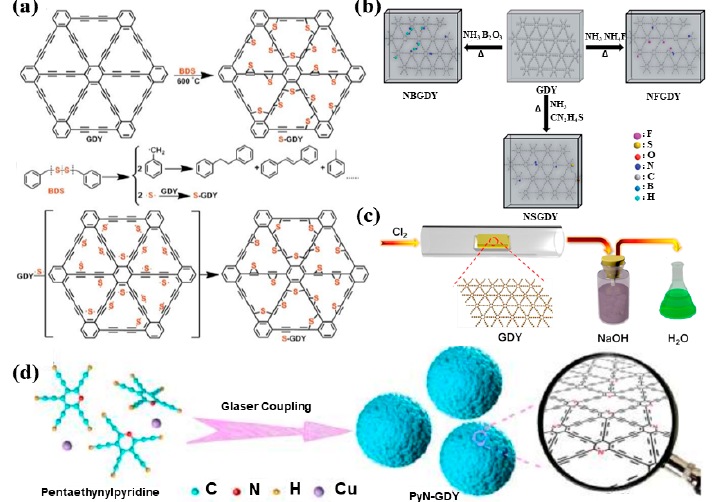
Figure 5. Syntheses of nonmetallic-atom-doped GDY. ( a ) Schematic illustration of the preparation of S-GDY (reproduced with permission from [77] . Copyright Wiley-VCH, 2019); ( b ) schematic drawing for the fabrication of multielement-doped-GDY-based materials (reproduced with permission from [79] . Copyright The Royal Society of Chemistry, 2016); ( c ) schematic illustrate of the preparation process of Cl–GDY (reproduced with permission from [80] . Copyright American Chemical Society, 2019); ( d ) Schematic illustration of the synthetic route of PyN–GDY (reproduced with permission from [81] . Copyright Elsevier, 2019).